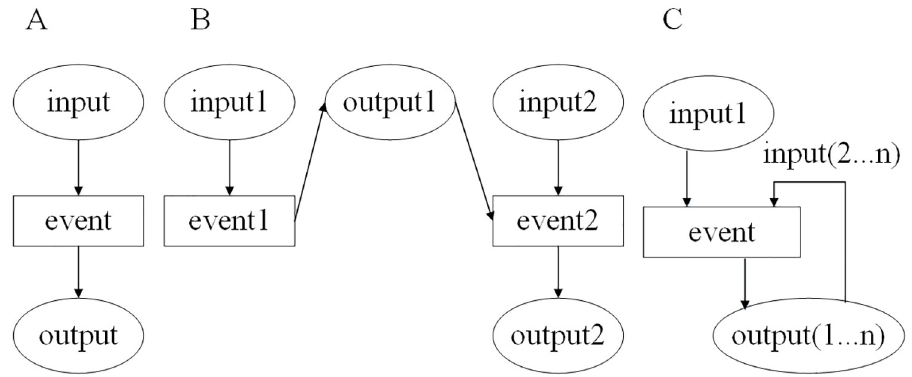
Fig 2. Three basic business process scenarios. A: A scenario of a single event. B: Scenario of a sequential event sequence. C: Scenario of a loop event sequence.